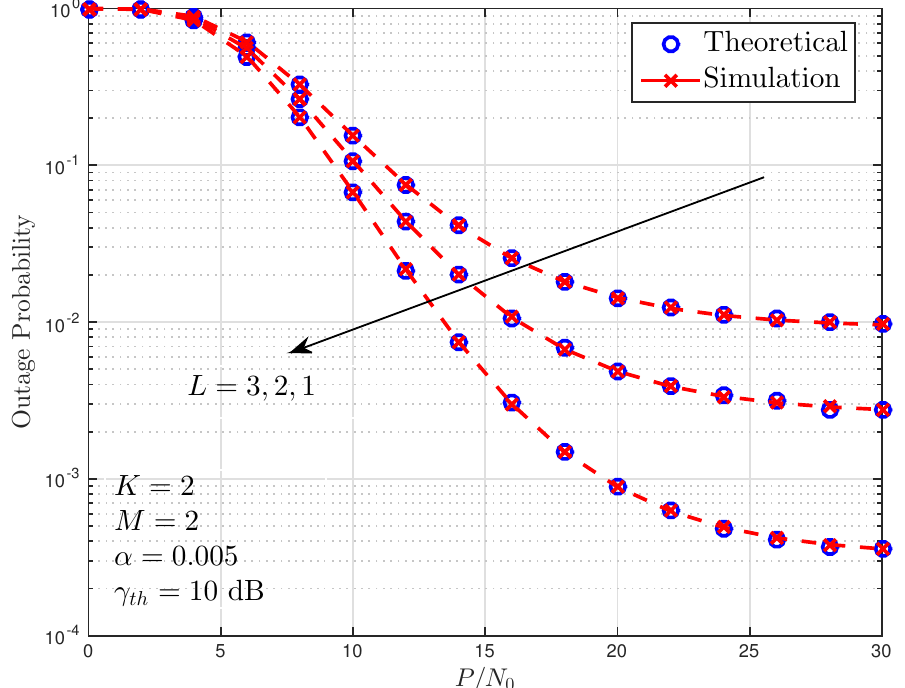
Figure 4. Outage probability of the secondary network versus P / N 0 for different numbers of primary users (interferers), when α = 0.005.